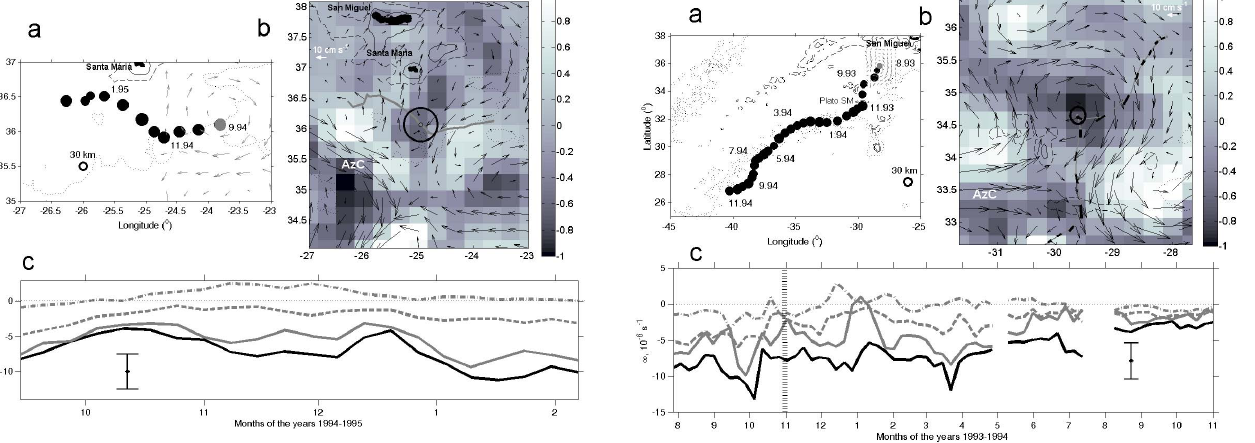
Fig. 2. Same as Fig. 1, but for meddy Hyperion (the direction of meddy movement is to southwest); (b) shows the AVISO derived geostrophic currents on 22.09.1993.